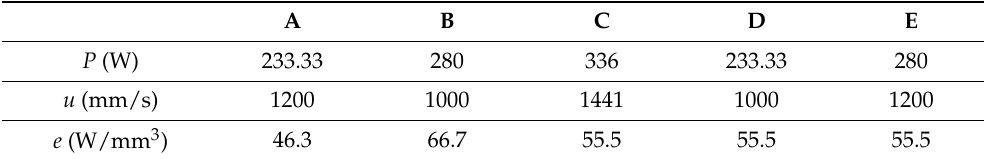
Table 1. Infill laser power ( P ) and infill laser scan speed ( u ) values applied for groups of test specimens denoted by A–E, and energy input ( e ) calculated from SLM